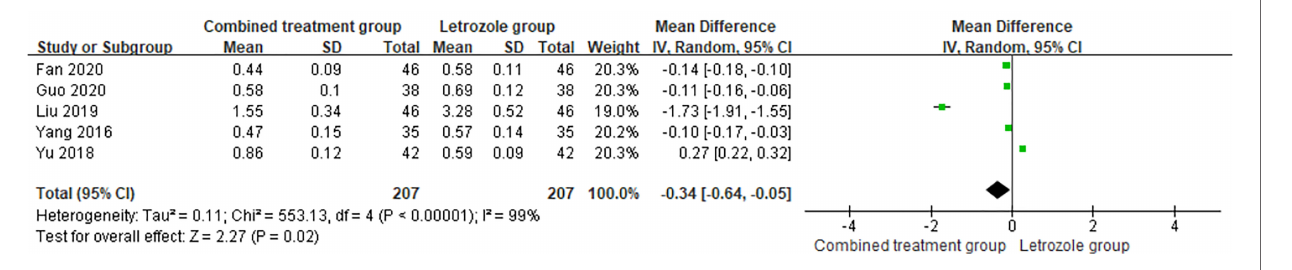
FIGURE 9 | Meta-analysis of the effect of Kuntai capsule combined with letrozole on testosterone (T) in the treatment of polycystic ovary syndrome (PCOS).